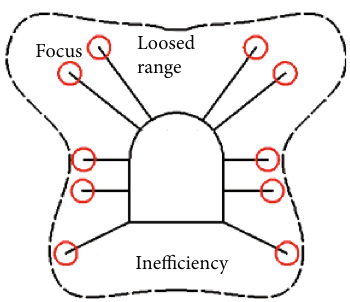
Figure 13: Misled roadway support system under a high deviatoric stress.